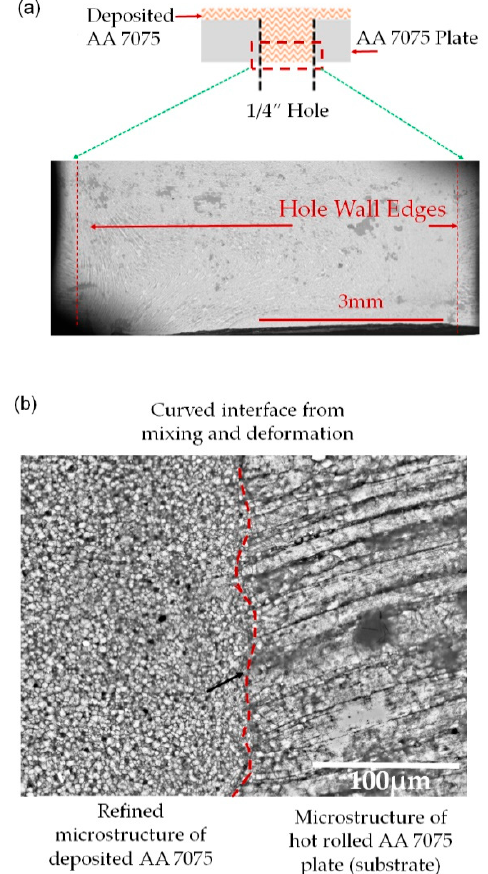
Figure 4. ( a ) Lower magnification micrograph of the cross-section showing no apparent defects after repair; ( b ) A zoomed-in image of the interface on the right side of Figure 4a.